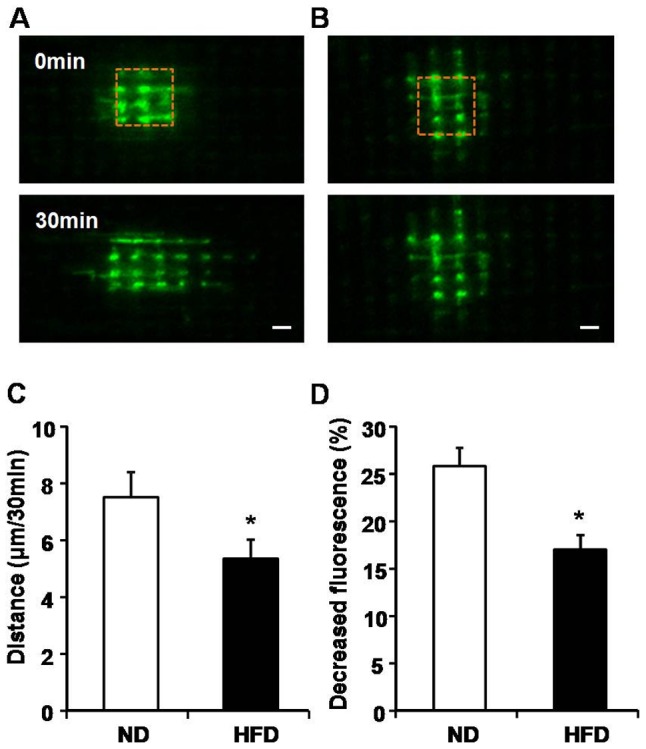
Inhibition of mitochondrial dynamics in skeletal muscle of HFD-induced mice.A and B, Representative confocal images showed the propagation of activated mtPAGFP in normal diet (ND) (A) and HFD-induced mice (B) 30 min after photoactivation. Dashed brown rectangle indicated photoactivated region with a size of 6.0 μm×6.0 μm. C and D, Statistic analysis on propagated distance (C) along longitudinal direction of the cell and decreased fluorescence of mtPAGFP of activated region (D) in (A) and (B). n = 6 mice for each group. *, P<0.05 compared to ND.